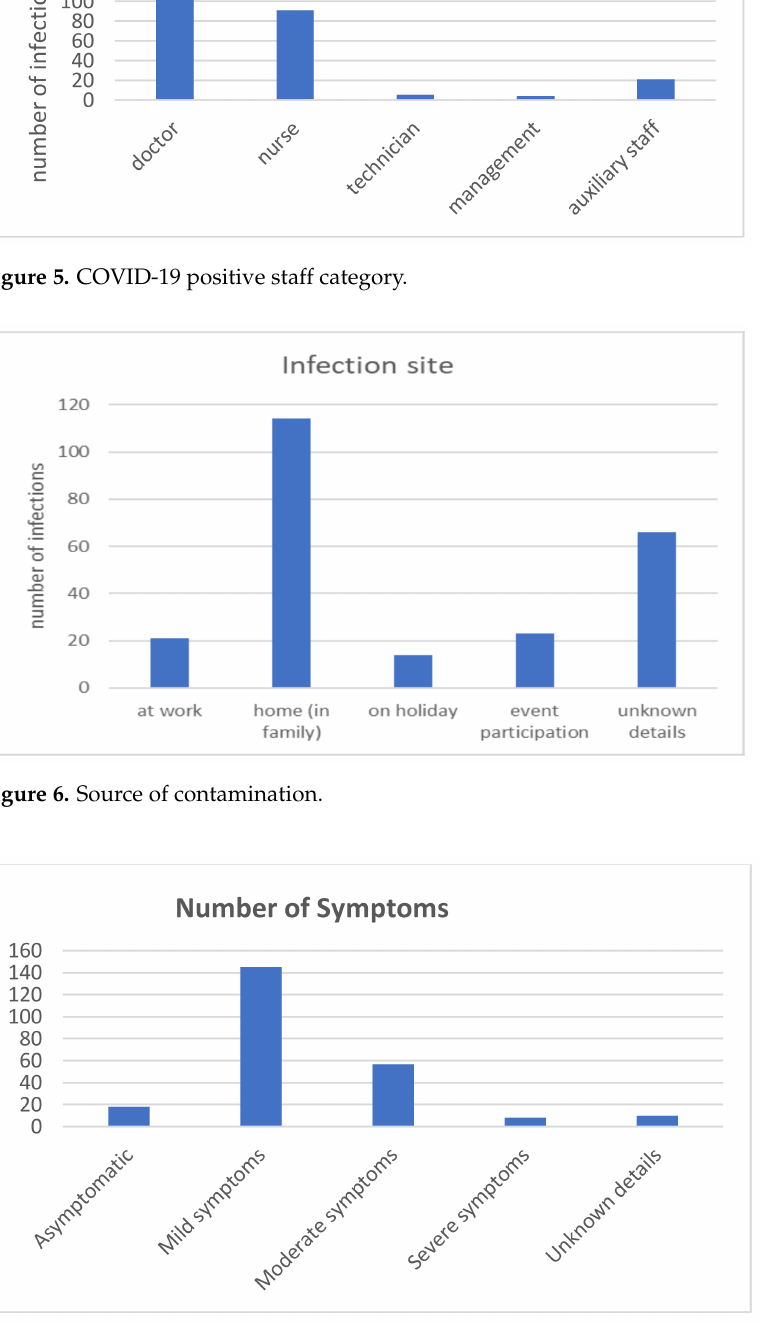
Figure 7. Symptoms of the infected dental